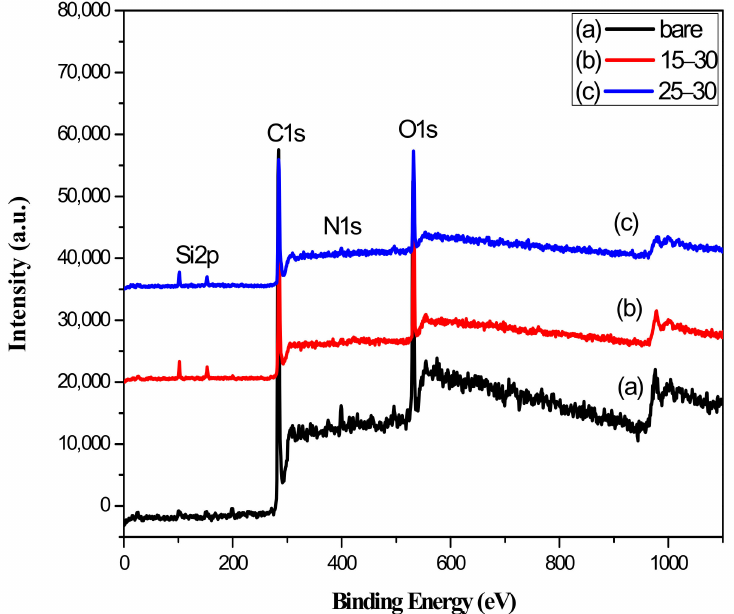
Figure 3. XPS spectra of uncoated sample and coated samples: ( a ) bare; ( b ) deposition time 30 s and spraying distance 15 mm; ( c ) deposition time 30 s and spraying distance 25